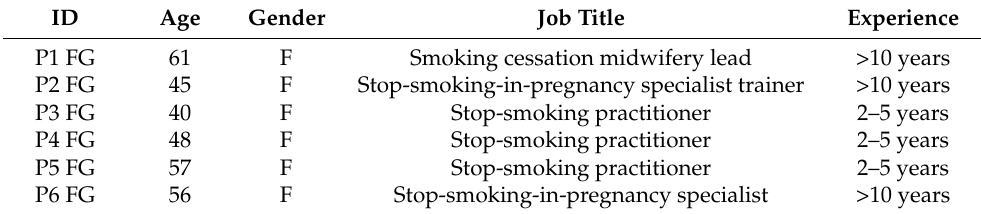
Table 3. Characteristics of stop-smoking